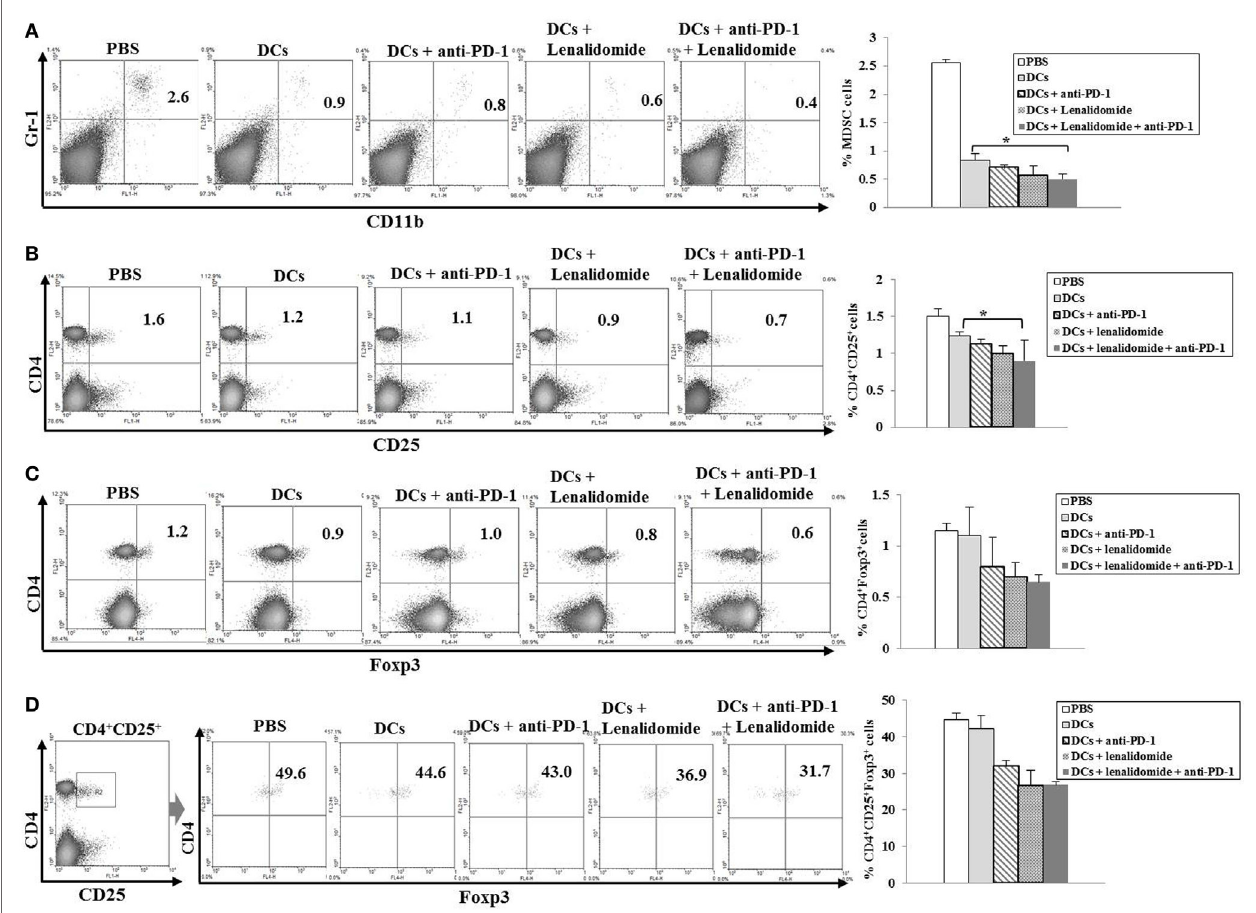
FigUre 4 | Inhibition of myeloid-derived suppressor cells (MDSCs) and regulatory T cells (Tregs) in the spleens of mice treated with dendritic cells (DCs) plus lenalidomide and anti-PD-1 We measured proportions of (a) MDSCs (CD11b + Gr-1 + ), (B) CD4 + CD25 + Tregs, (c) CD4 + Foxp3 + Tregs, and (D) CD4 + CD25 + Foxp3 + Tregs using flow cytometry (left panel) and compared them using quantitative bar graphs (right panel). The proportions of MDSCs and Tregs were significantly increased in the PBS control and DC vaccination groups compared to the groups injected with lenalidomide or anti-PD-1 after tumor inoculation. The DC vaccination plus lenalidomide and anti-PD-1 combination group showed significantly decreased proportions of splenic MDSCs and Tregs compared to the other groups (* P < 0.05). Data are representative of at least three